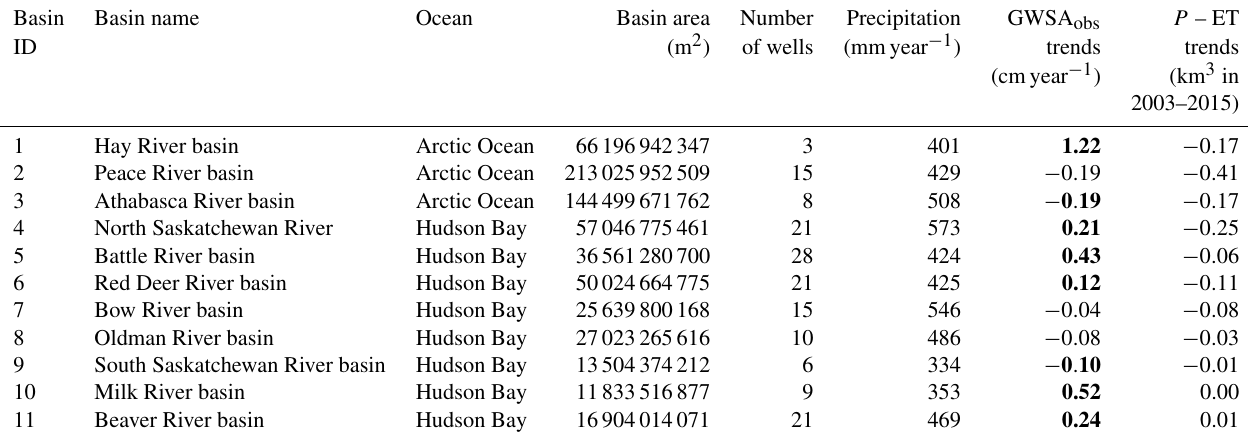
Table 1. Details of the river basins used (within Alberta only), number of wells used, precipitation, and GWSA obs trends (statistically significant ( p value < 0 . 01) trend estimates are shown in bold).